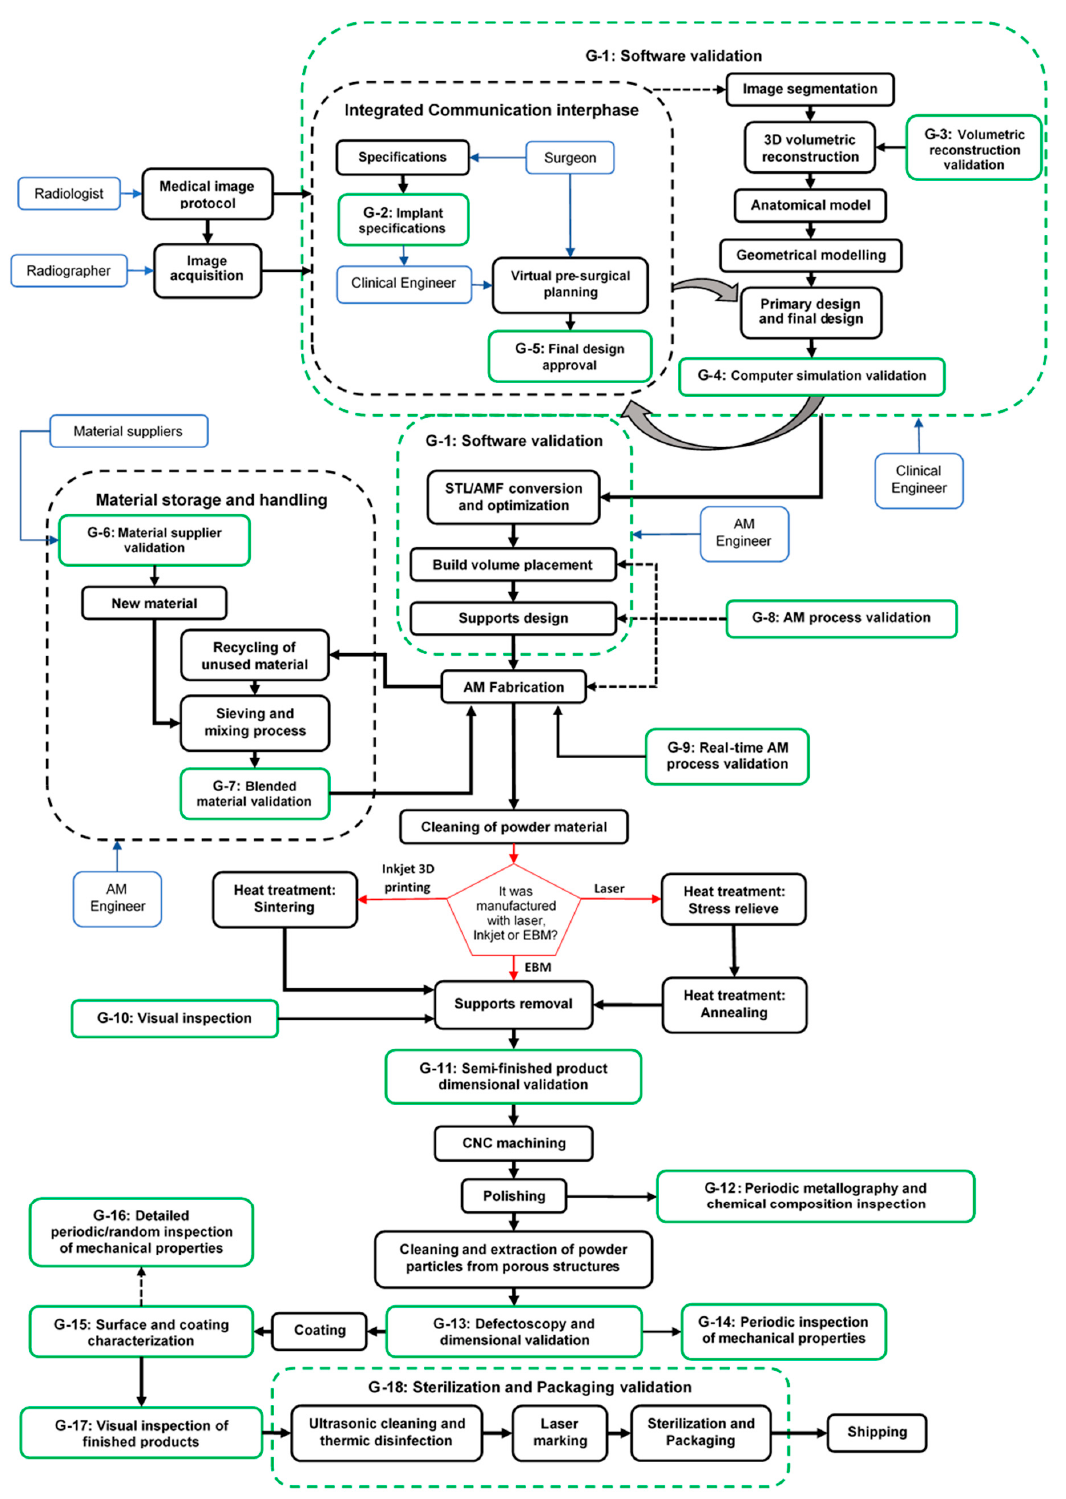
Figure 2. Integrated quality control workflow chart with the 18 gates for the design and fabrication of patient-specific implants by AM. The meanings of the operators in the chart are as follows: black solid outlined boxes = processes; black dash outlined boxes = overarching processes; green solid outlined boxes = quality control gates; green dash outlined boxes = overarching quality control gates; red pentagonal boxes = decision gate; blue boxes = experts/staff; solid arrows = on-line processes; dashed arrow = off-line processes.